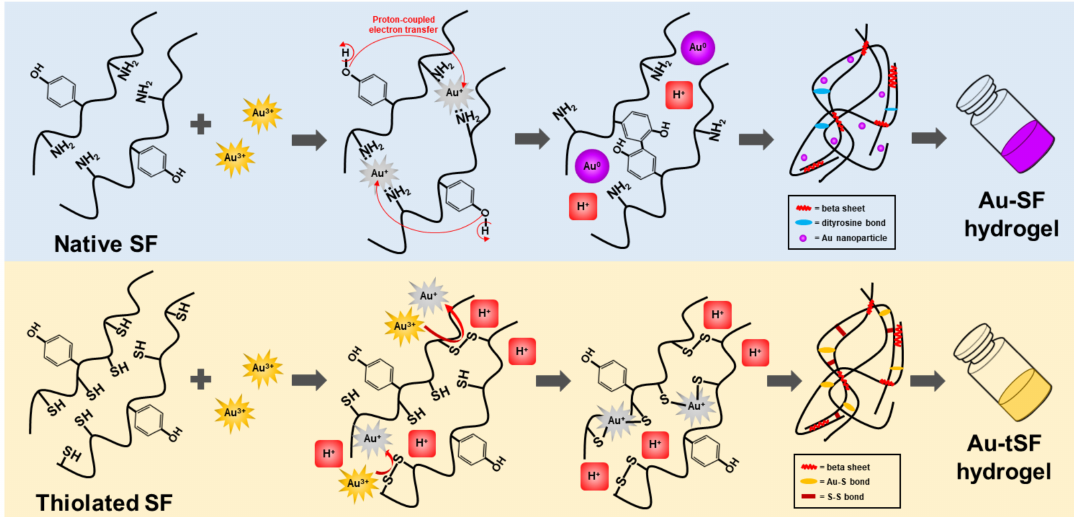
Figure 8. Proposed gelation mechanism of Au-SF and Au-tSF hydrogels. For SF, amino groups of protein side chains firstly coordinate with Au 3 + and reduce to Au + . Tyrosine residues then donate electrons via proton-coupled transfer reaction to Au + and reduce to Au, leading to dityrosine bonding and AuNPs formation. Protons (H + ) are generated and induce SF beta sheet transition. For tSF, thiol groups donate electrons to Au 3 + , resulting in Au + , and form disulfide bonds. Subsequently, Au + form bonds with available thiol groups without further reduction. The generation of H + from S-S and Au-S bonds results in a beta sheet formation of